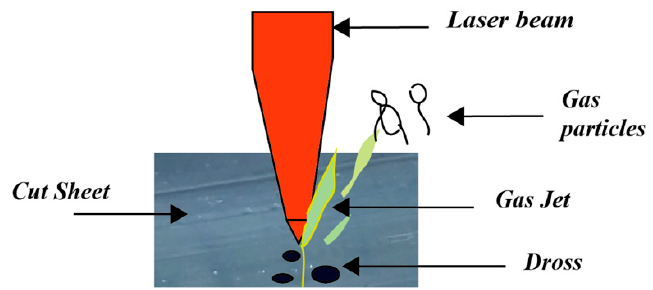
Figure 6. Representation of Dross formation during laser cutting.